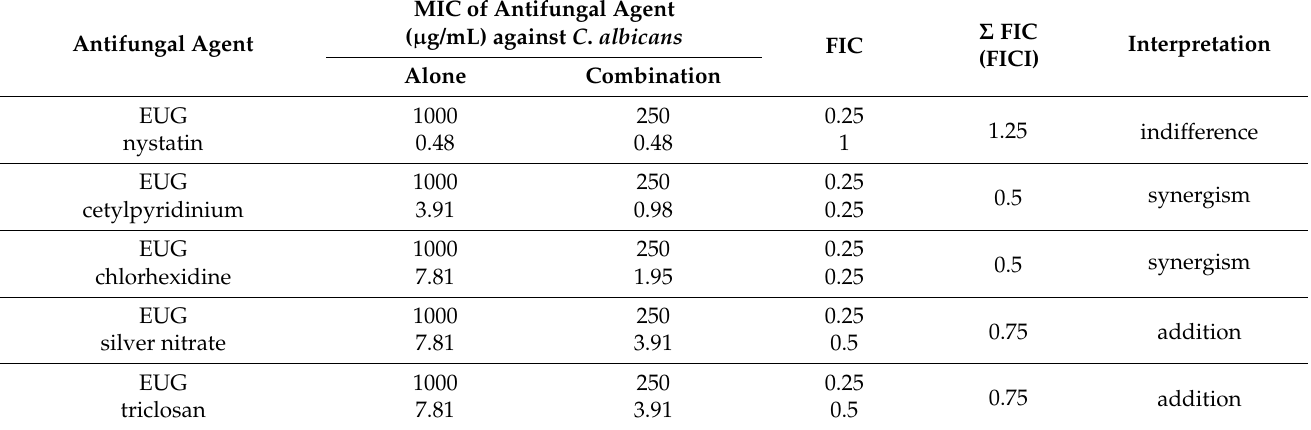
Table 9. MICs and FIC indices of EUG alone and in combination with selected antimycotics on reference C . albicans ATCC 10231